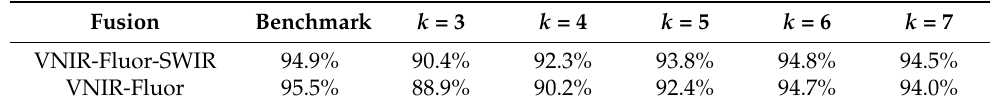
Table 6. Resulting average 4-fold cross-validation accuracies for the fusion of spectral modes in the input layer of the MLP classifier. The values in the “Benchmark” column refer to accuracies obtained using all wavelengths in each spectral mode.